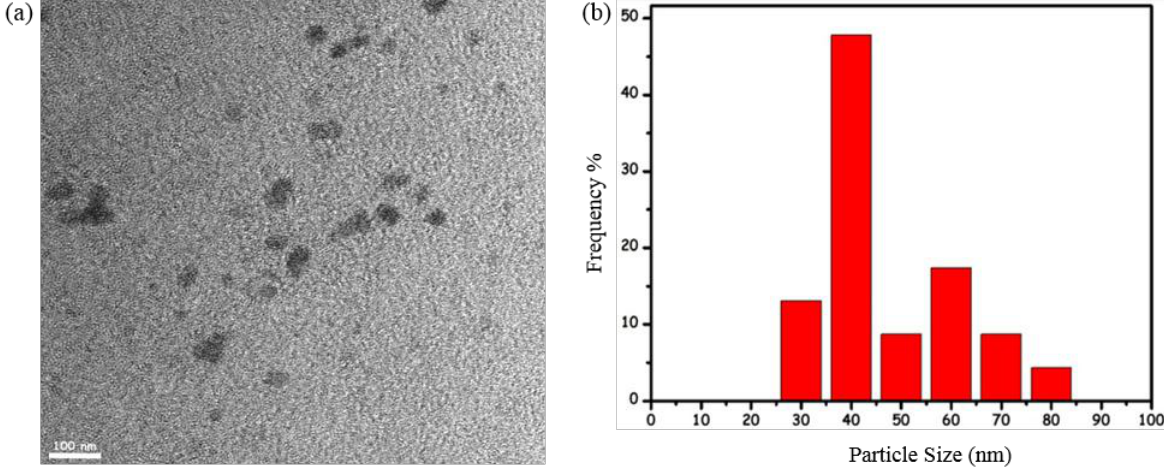
Figure 5. ( a ) TEM image of a dihydrogen phosphate anion stabilized ruthenium(0) NP sample harvested after the fifth run of hydrolysis of AB (the scale bar corresponds to 100 nm); and ( b ) corresponding size